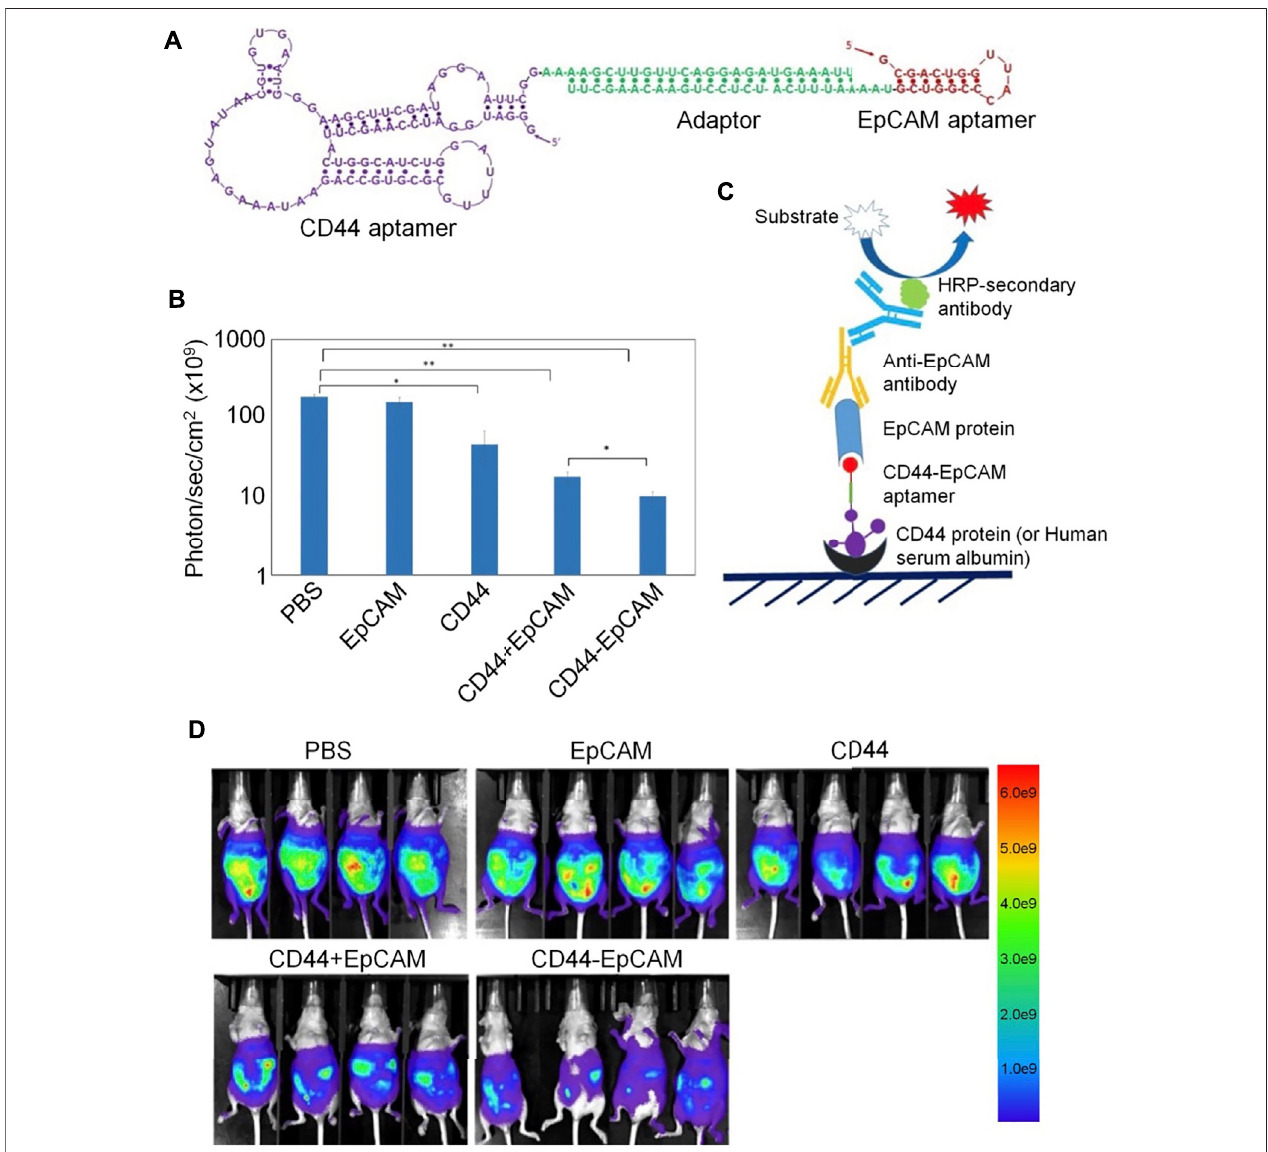
FIGURE 6 | Bispeci fi c aptamer-mediated therapy for ovarian cancer. (A) Structure of the CD44-EpCAM aptamer. (B) Quanti fi cation of CD44-EpCAM using ImageJ. (C) Schematic of ELISA for dual-speci fi city evaluation of the CD44-EpCAM aptamer. (D) Bispeci fi c aptamer-mediated therapy suppresses peritoneal tumor